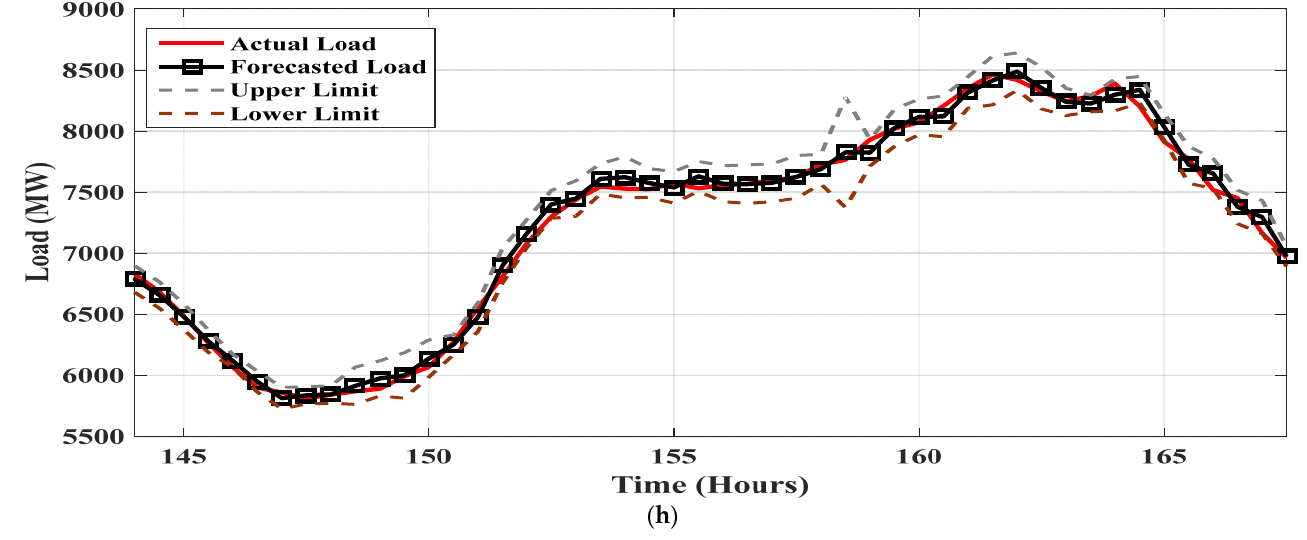
Figure 6. Forecasting in summer 1–7 Feb. 2016 with M5P + FS, ( a ) entire week, ( b – h ) daily forecast.